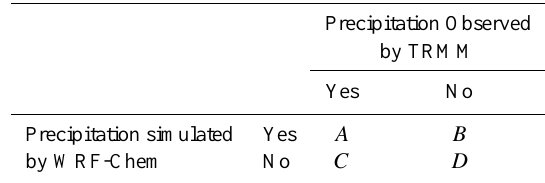
Table 2. Different symbols used in calculation of the hit rate statis-